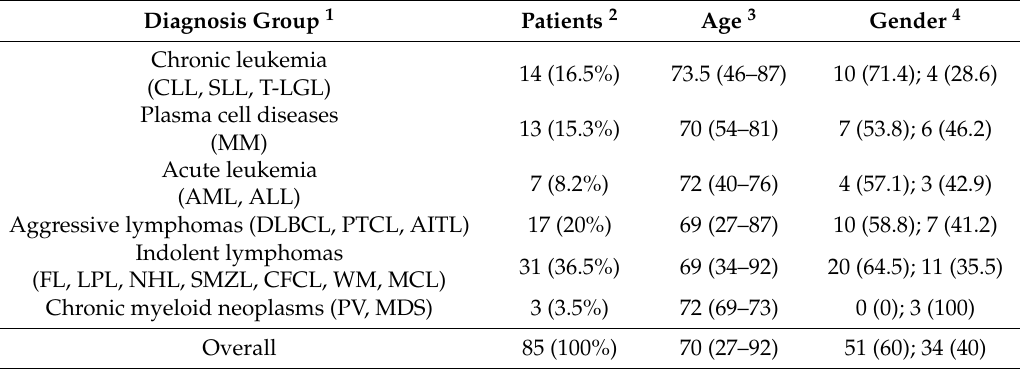
Table 1. Patient characteristics per diagnosis group.